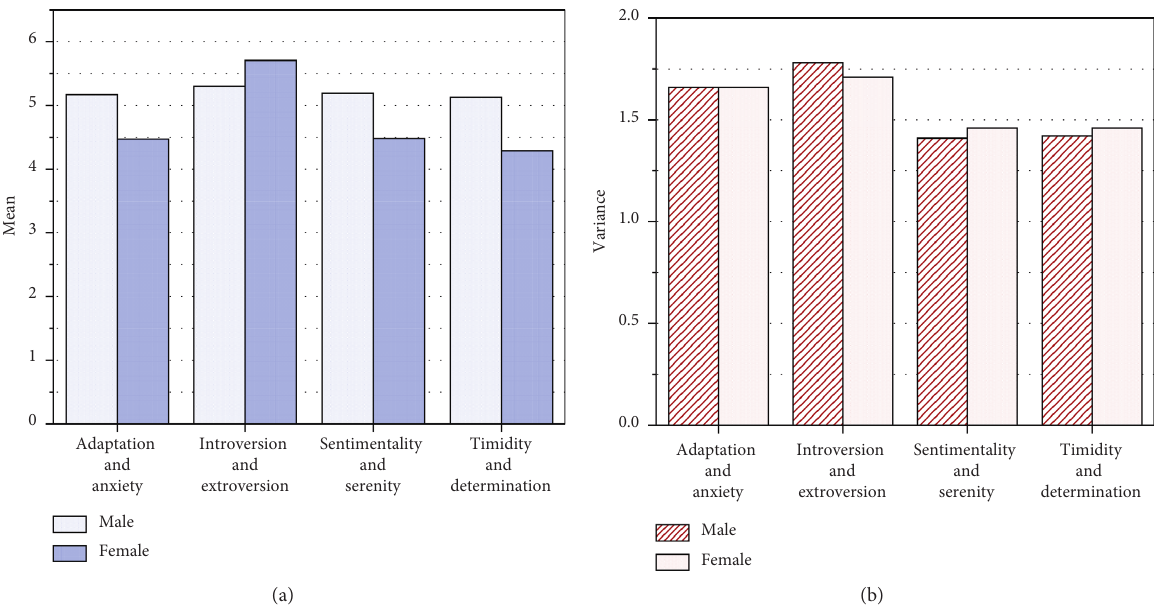
Figure 9: Difference chart of each variable between male and female students. (a) Distribution of mean. (b) Distribution of